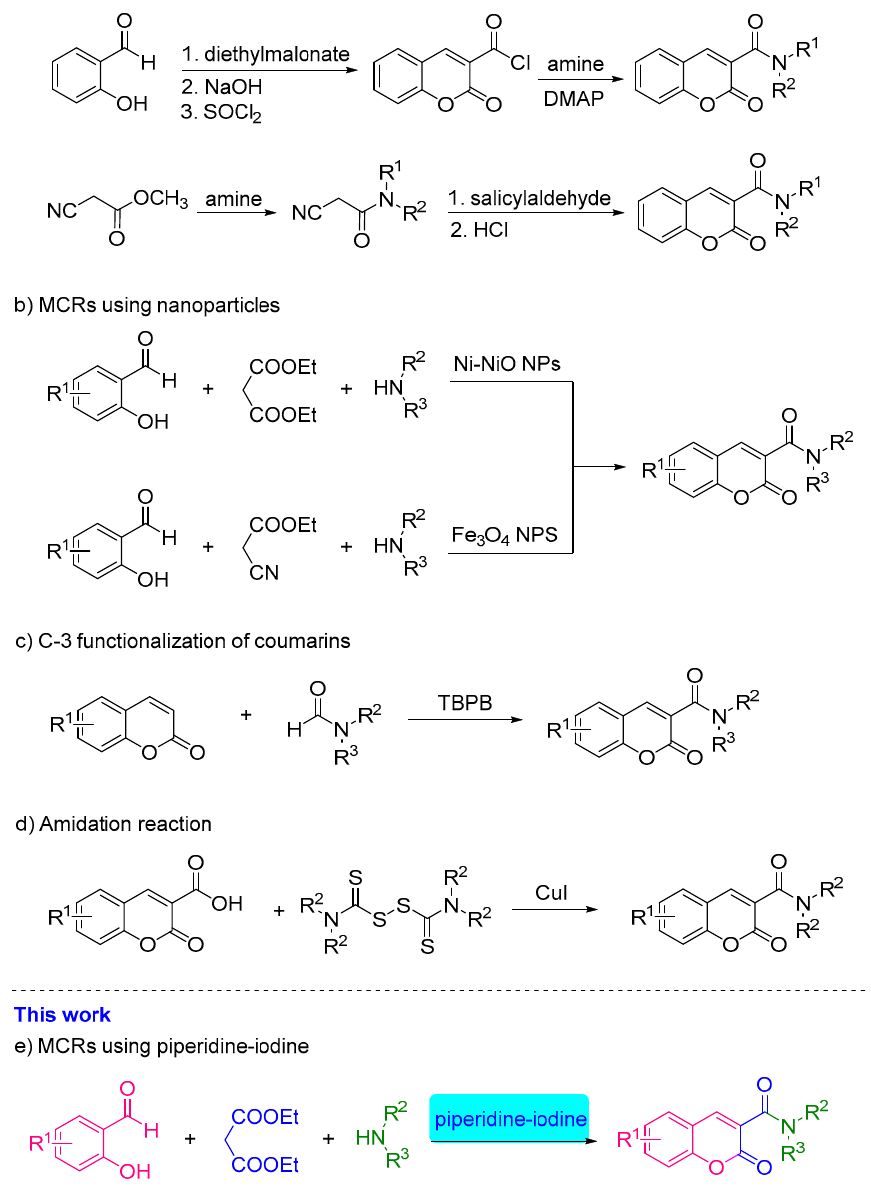
Figure 1. General methods for the synthesis of coumarin-3-carboxamides: ( a ) Traditional approach multistep reactions [22], ( b ) MCRs using nanoparticles [24,25], ( c ) C-3 functionalization of coumarins [26], ( d ) amidation reaction [27], ( e ) MCRs using piperidine-iodine.